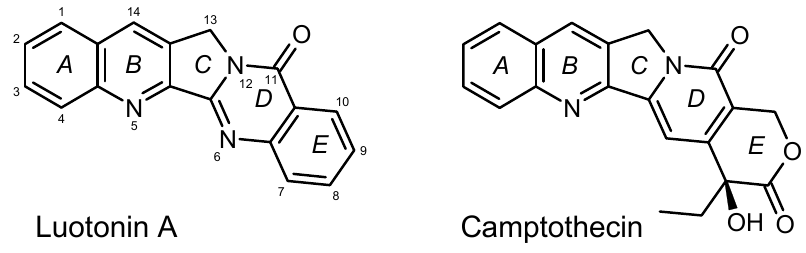
Figure 1. Structures of Luotonin A and Camptothecin (CPT).